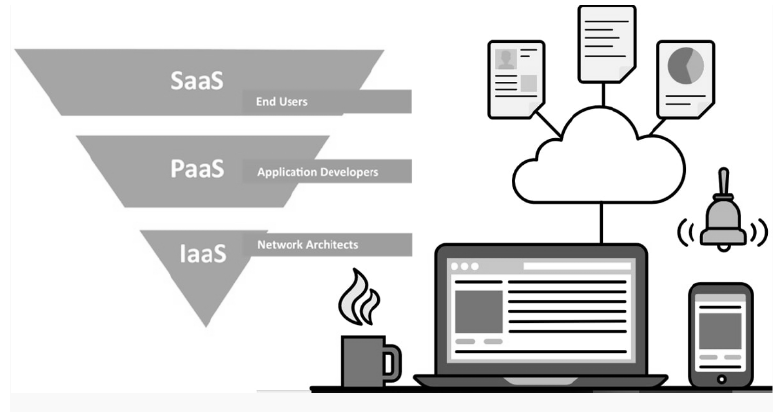
Figure 2. Delivery models of cloud services